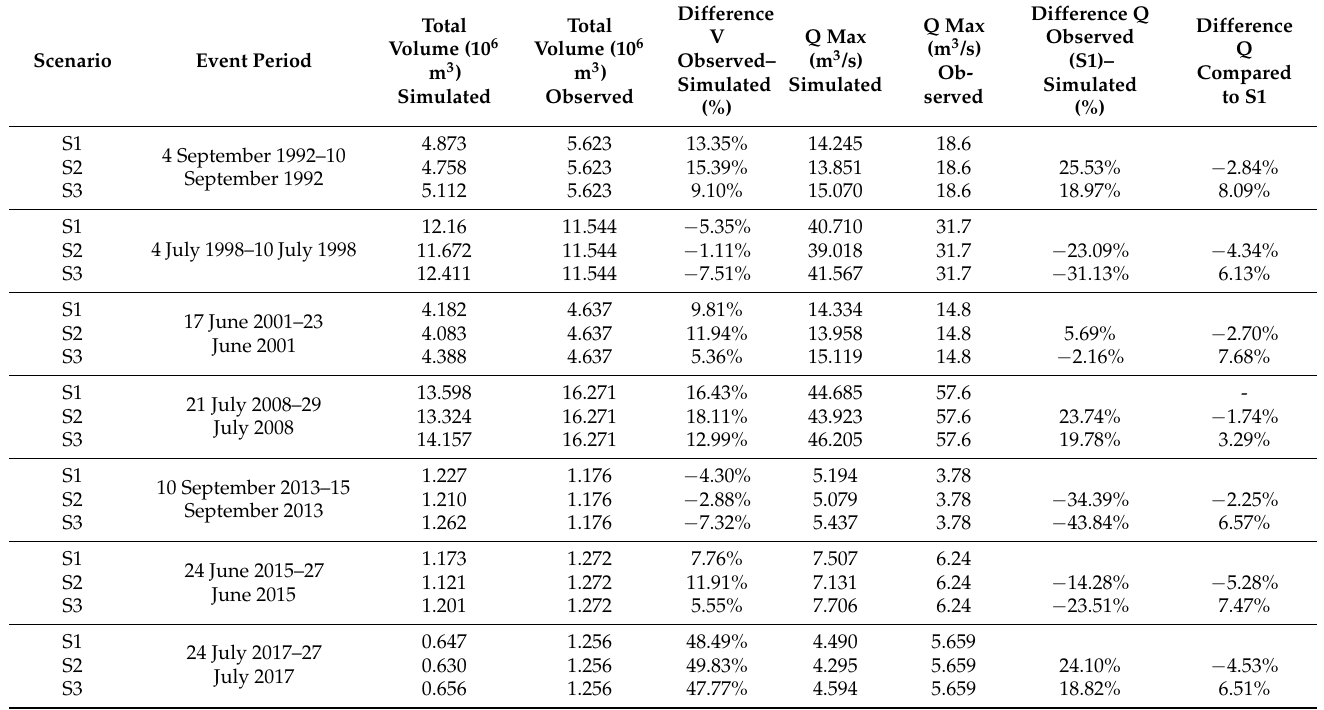
Figure 13. The values of the CN taken into account in the calibration. Table 5. The result of the simulations on the 3 scenarios.